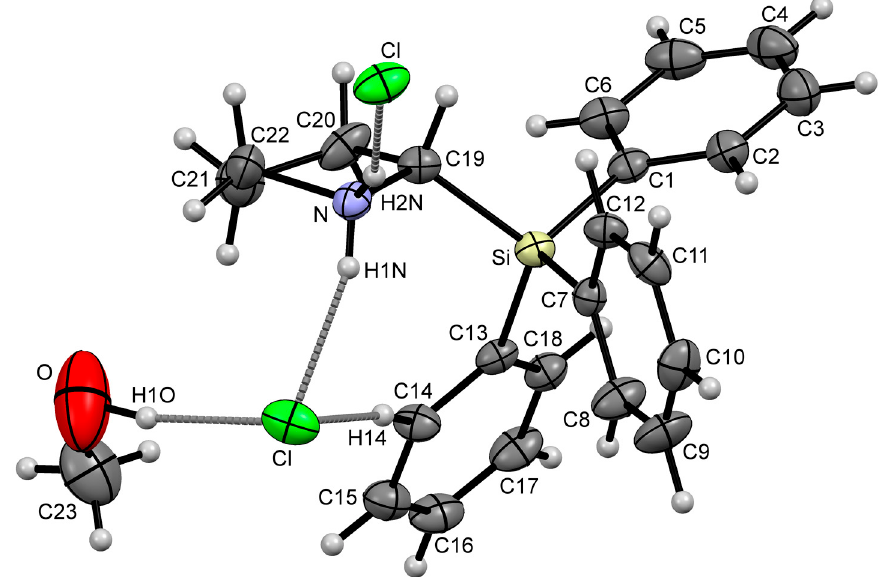
Figure 3. Part of the crystal structure (ORTEP plot) of compound ( S )- 1 ·HCl·MeOH in the crystal, with the displacement ellipsoids set at the 50% probability level. Selected bond lengths (Å) and angles (°):